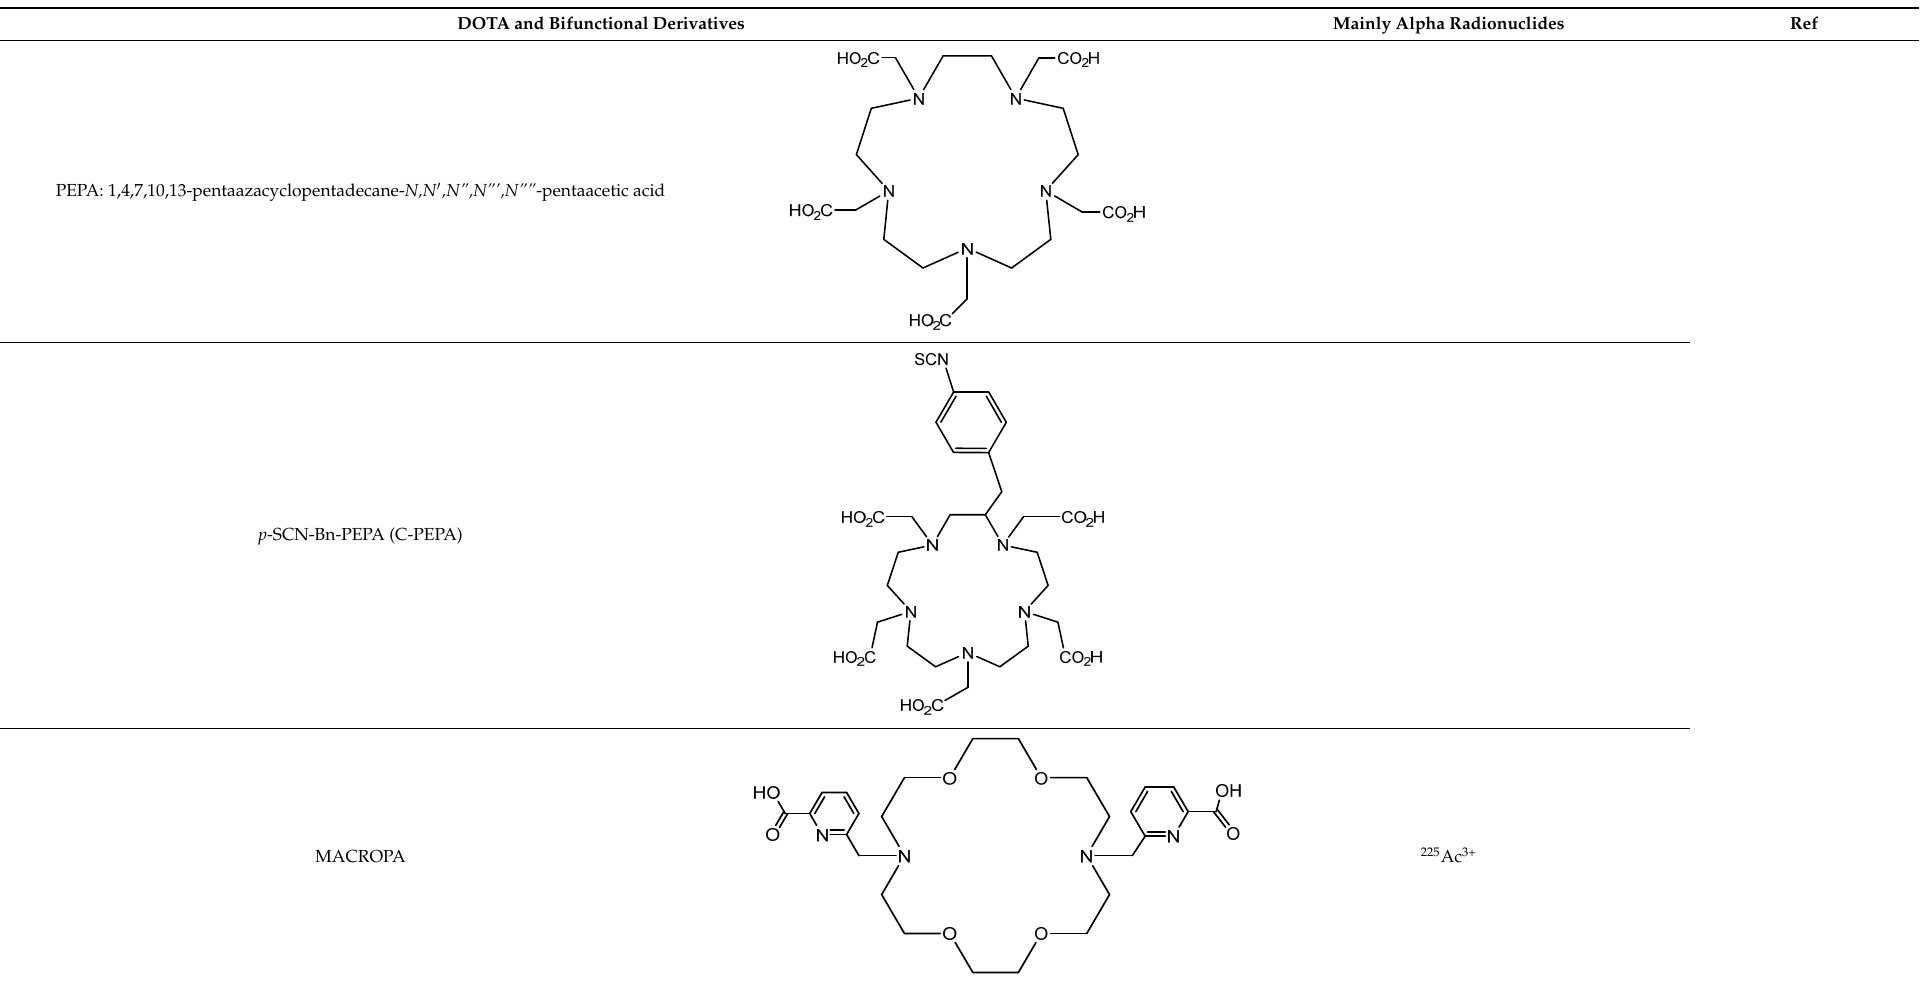
DOTA and Bifunctional